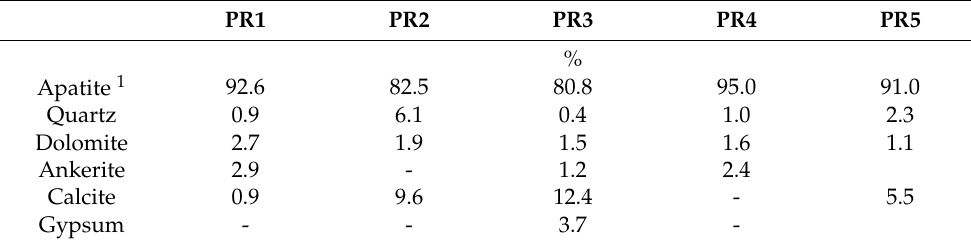
Table 7. The content of individual phases determined by the Rietveld